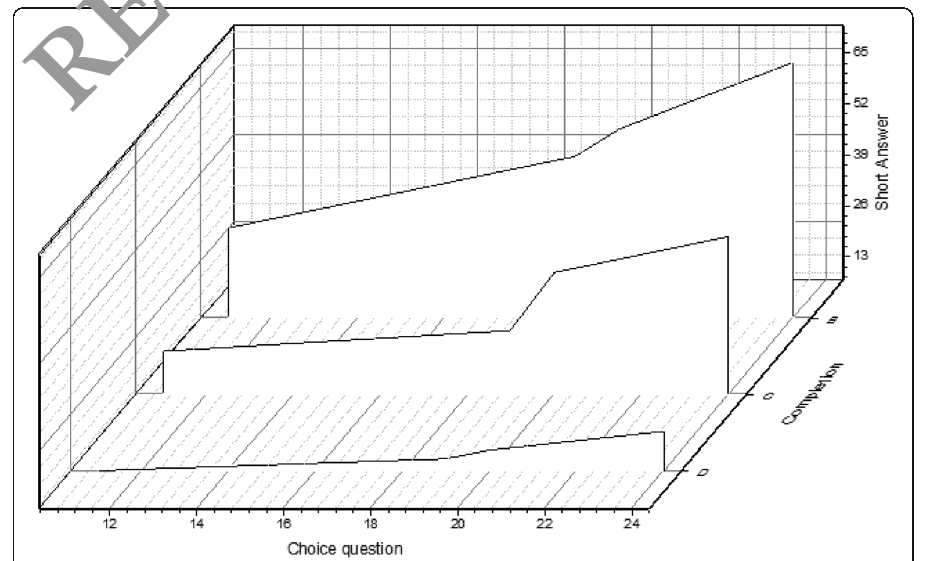
Fig. 4 Problem difficulty